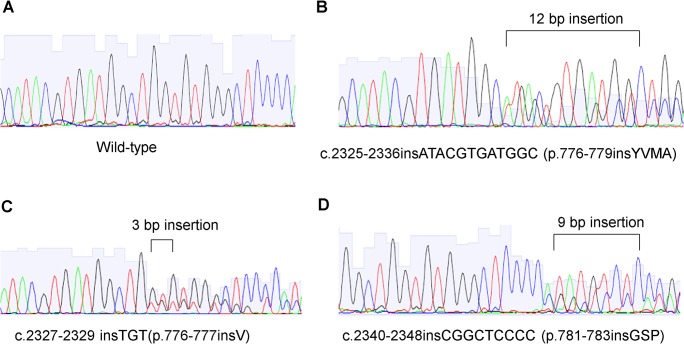
Sanger sequencing reads demonstrating mutational patterns of HER2 exon 20.(A) Wild-type sequence. (B) A 12-bp duplication/insertion of the amino acid sequence YVMA between codon 776 and 779. (C) A 3-bp insertion of the amino acid sequence VC at codon 776. (D) A 9-bp insertion of the amino acid GSP between codon 781 and 783.